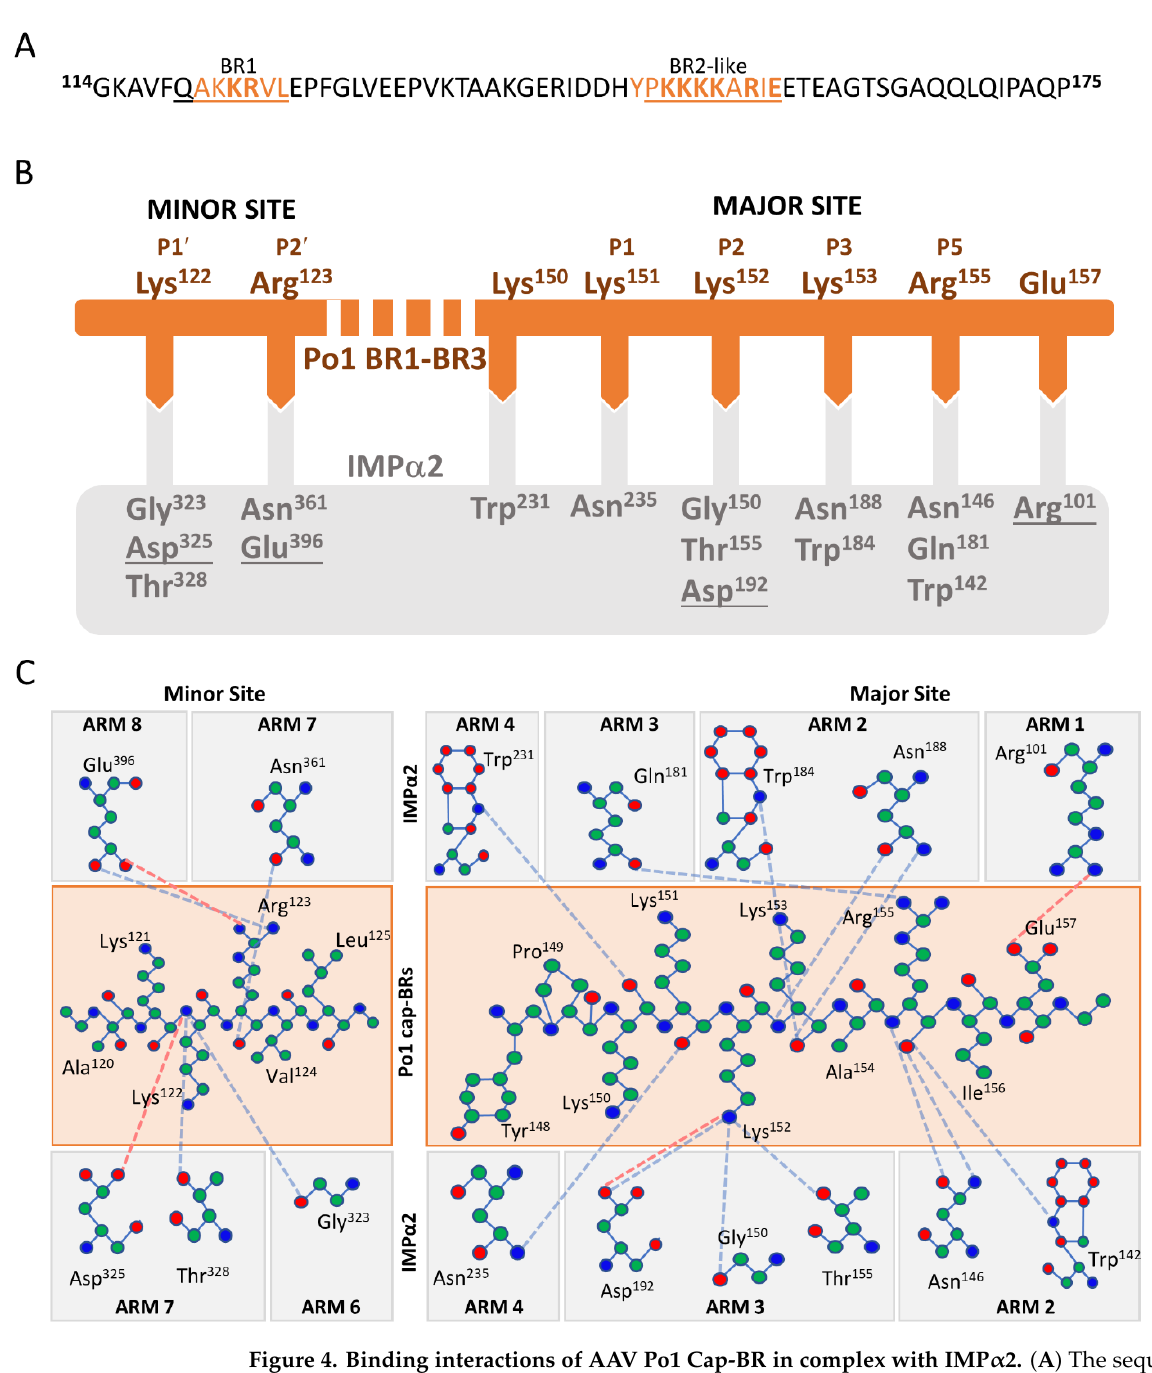
Figure 4. Binding interactions of AAV Po1 Cap-BR in complex with IMP α 2. ( A ) The sequence of AAV Po1 Cap-BR used in this study, where black represents the entire sequence used to generate complexes, underlined regions show the basic regions (BR1 and BR3 indicated from the literature with BR2 indicated via alignment with AAV5), orange indicates residues that can be fitted with confidence into the IMP α 2 crystal structure, and residues in bold have direct binding interactions with IMP α 2. ( B ) Simplified representation of IMP α 2 and AAV Po1 Cap-BR binding interactions. The AAV Po1 Cap-BR (orange line) residues bound to IMP α 2 (grey box) as indicated through complementary arrows. Salt bridges are indicated via underlined IMP α 2 residues, and non-underlined residues indicate hydrogen bonds. ( C ) A schematic overview of the interactions occurring through IMP α 2 residues, and corresponding ARMs (grey boxes) and AAV Po1 Cap-BR residues (orange box) in sequence order. Binding interactions are displayed through hydrogen bonds (blue dotted lines) and salt bridge interactions (red dotted lines) as indicated by the PDBsum